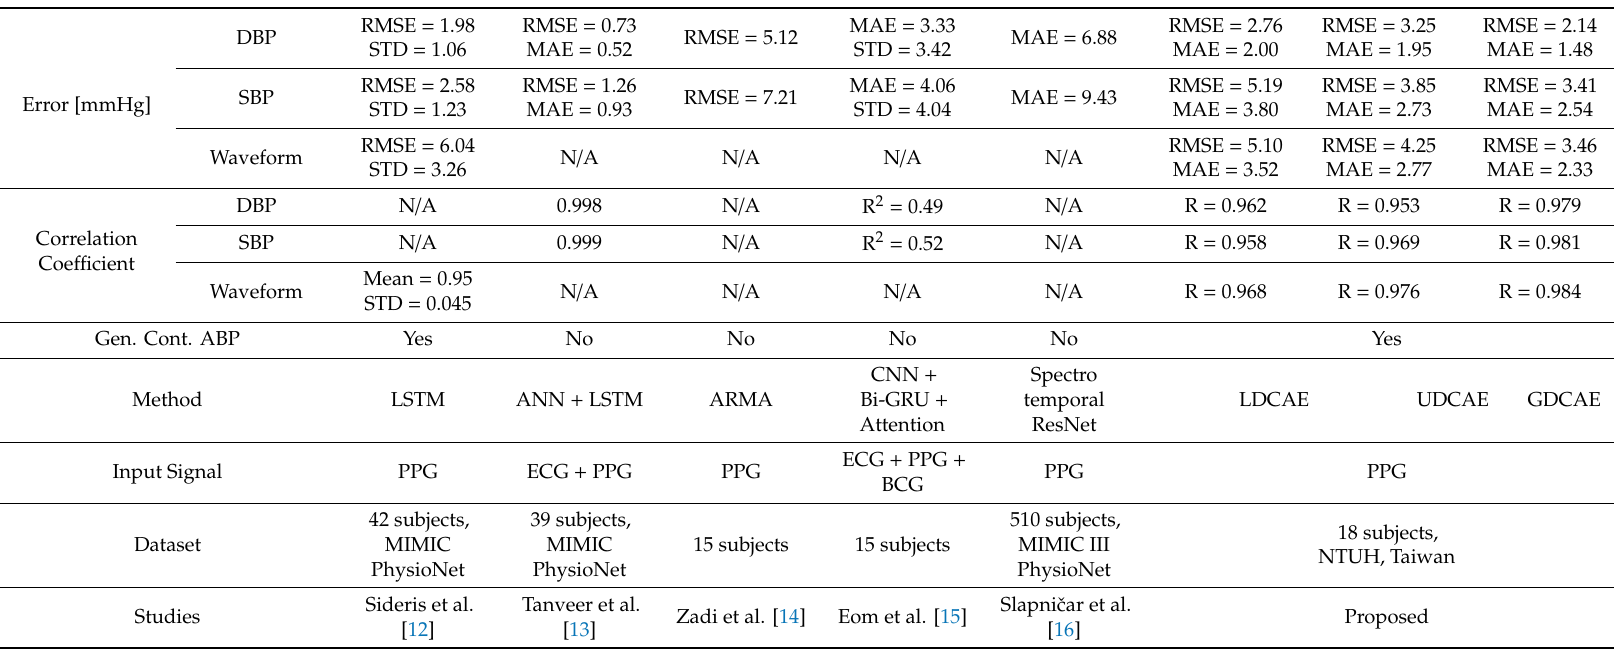
Table 5. Comparative Results for Dataset and Methodology Between the Proposed Method and Previous Related